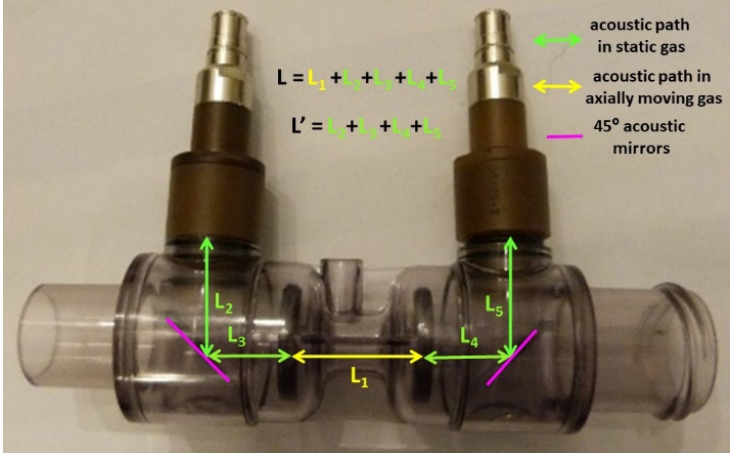
Figure 5. Acoustic cell geometry of the ultrasonic flowmeter used in North American Drager Narkomed GS and 6000 anesthesia workstations.